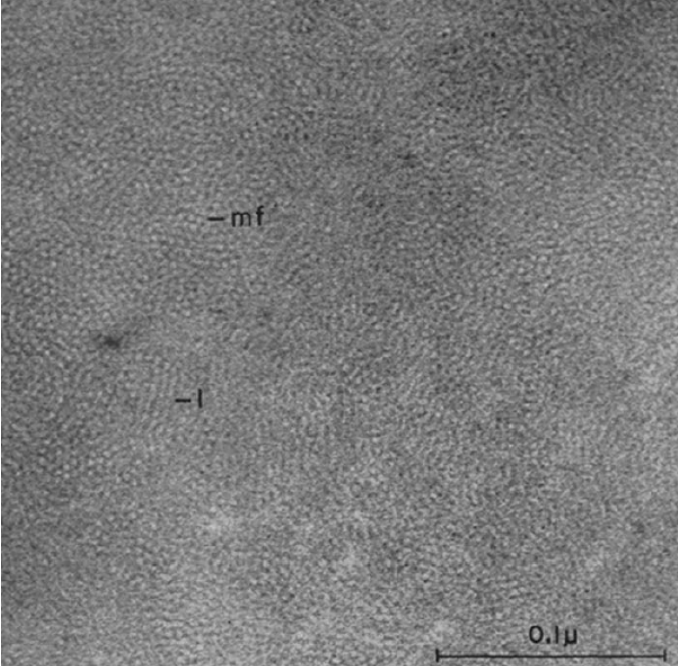
Figure 2. Transmission electron micrograph of a cross-section of feather keratin showing